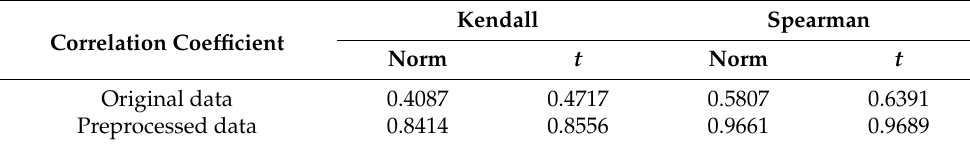
Table 1. Wind speed-power correlation coefficient.